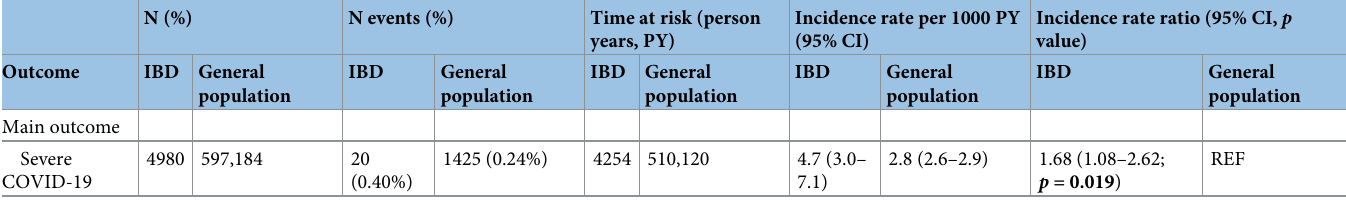
Table 1. Risk of severe COVID–19 ( i . e . hospitalization) in IBD patients and the general population in South–Limburg between February 27, 2020 and January 4,